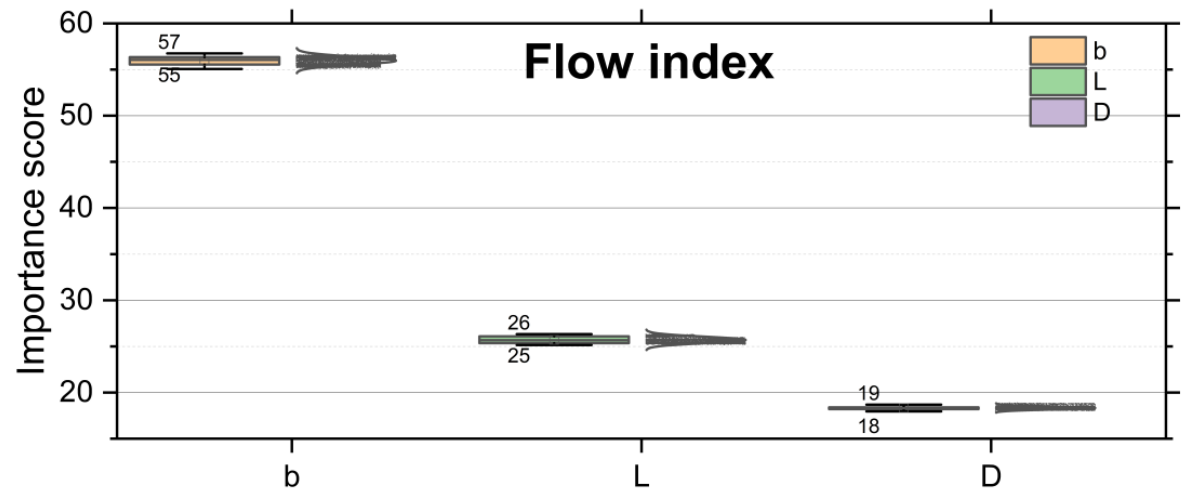
Figure 15. Importance scores of the input variables for the flow index prediction model.